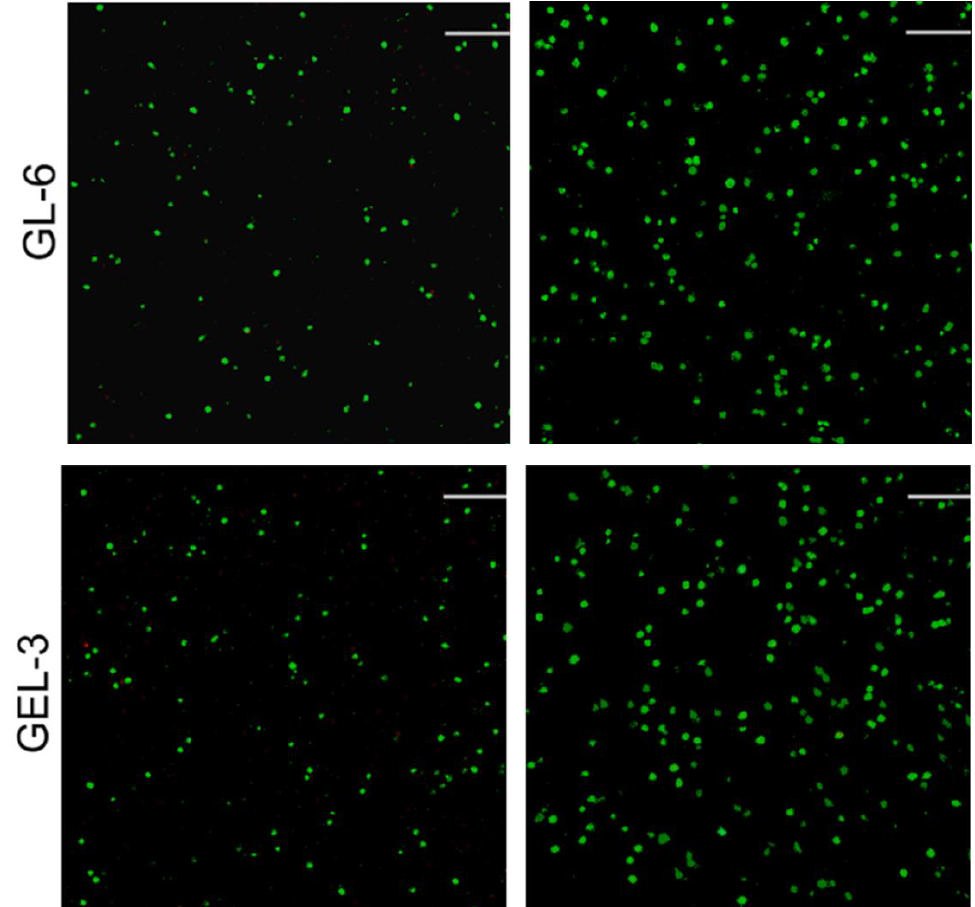
Figure 7. Confocal images for stained MC3T3-E1cells that were seeded GL-6 and GEL-3 gels (green: viable cells; red: dead cells; scale bar: 100 μm ; culture time: 3 days (left column) and 7 days (right column)). Figure 8a delineates the results for the cell proliferation in different gel matrices. It